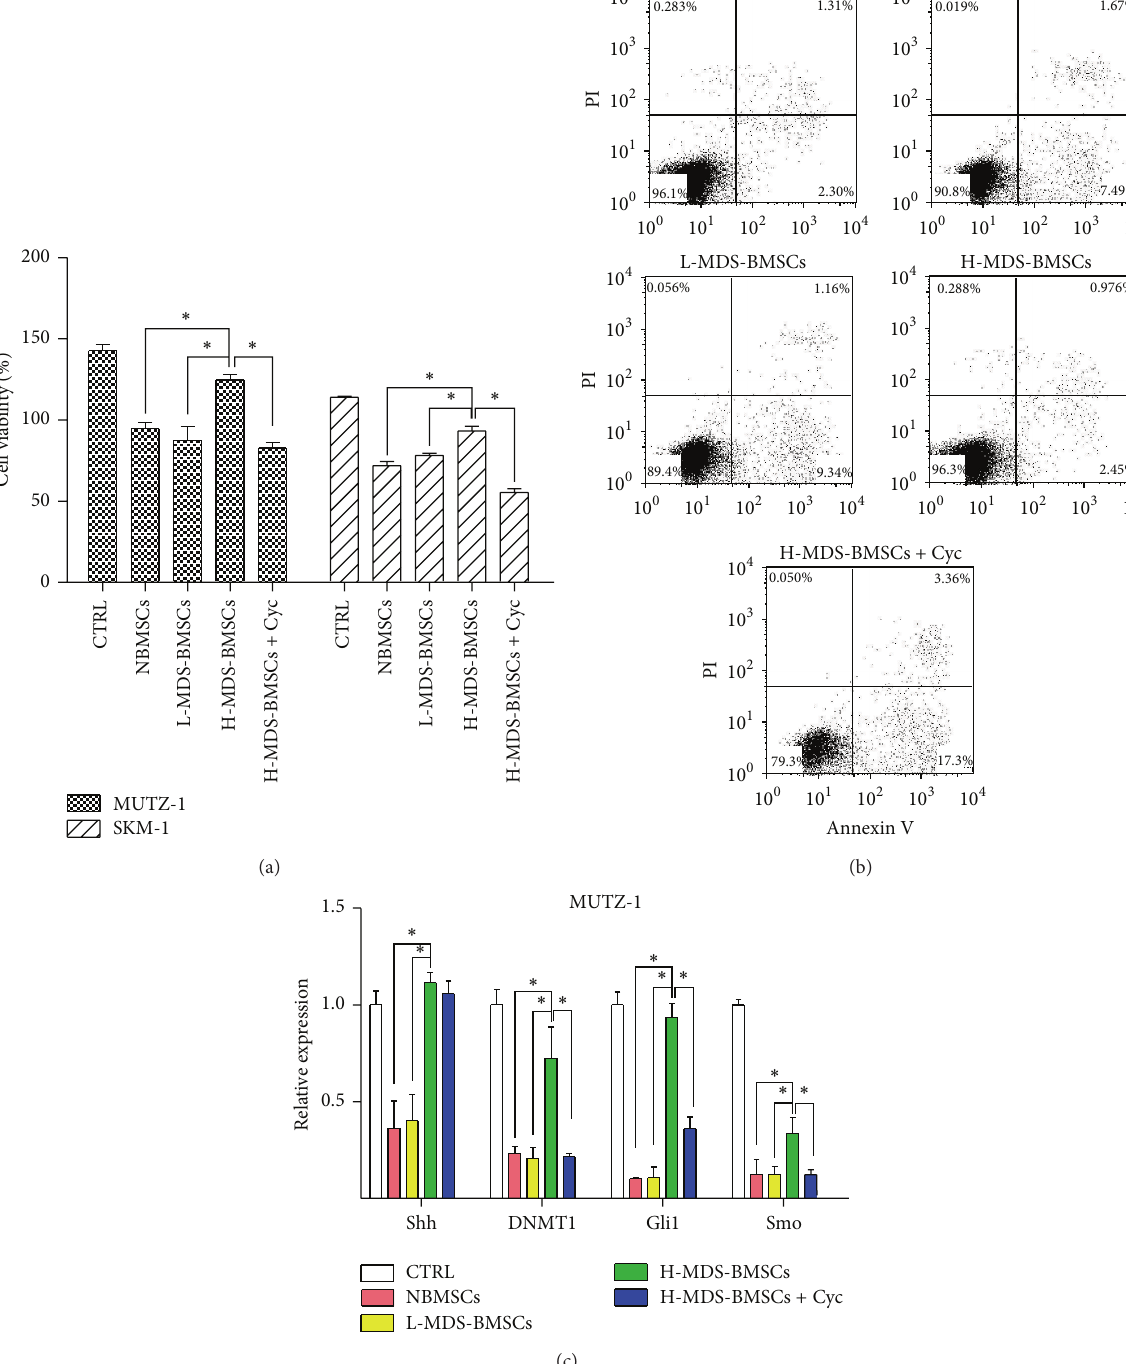
Figure 2: Inhibition of Shh signaling prevents BMSC-induced MUTZ-1 and SKM-1 cell survival. Proliferation and representative flow cytometric profile of MUTZ-1 cells cultured in the presence of control medium (CTRL) or BMSCs from normal (NBMSCs)/low-risk (L- MDS-BMSCs)/high-risk (H-MDS-BMSCs) MDS cases or high-risk MDS BMSCs with cyclopamine (Cyc) were determined by CCK8 assay (a) and Annexin V-PI assay (b). Expression of Shh, DNMT1, Gli1, and Smo was determined by real-time PCR (c). ∗ 𝑃 < 0.05 . Data shown are from three independent experiments done in triplicate. Results are expressed as mean ±